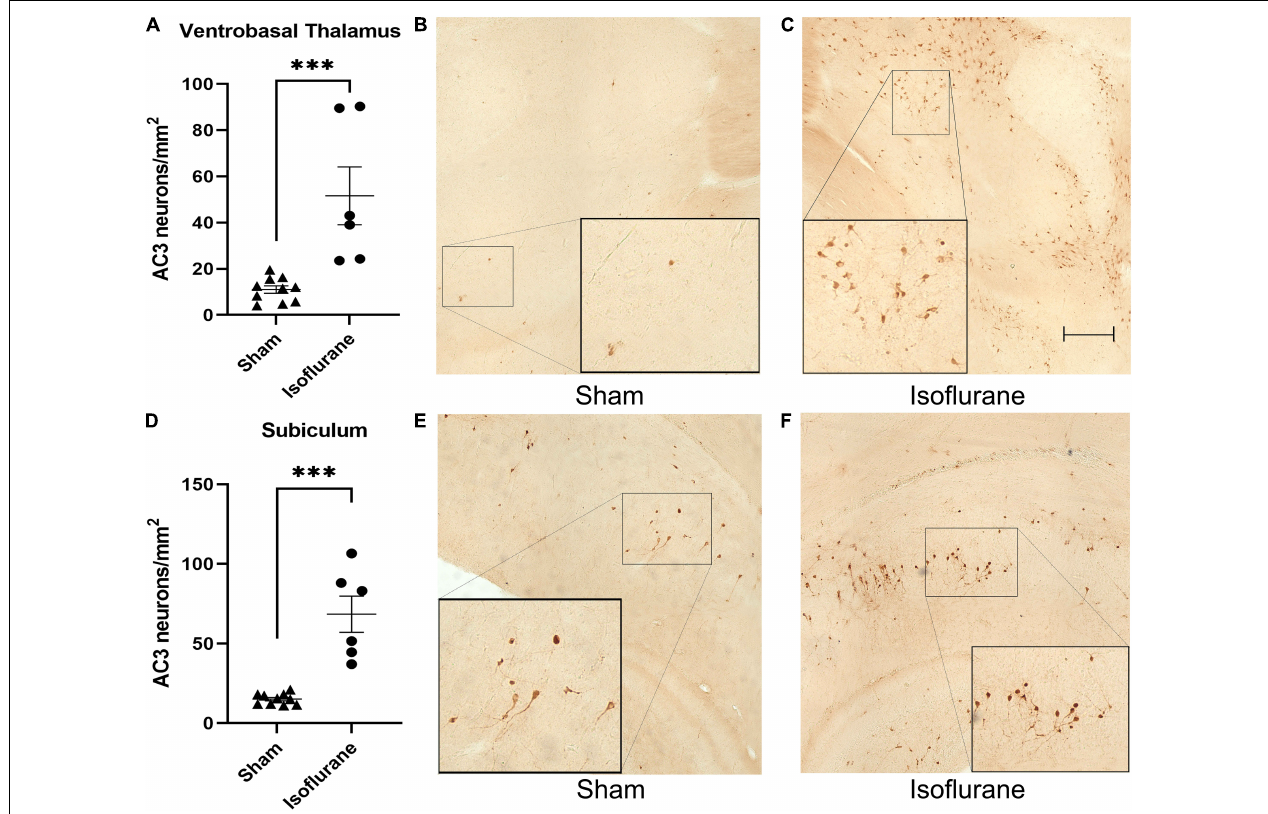
FIGURE 2 | Neonatal isoflurane exposure causes profound acute neurotoxicity. (A) Quantification of AC3 + neurons showing increased apoptotic profiles in the ventrobasal thalamus of rat pups 2 h after isoflurane exposure (*** P = 0.0002). (B,C) Side by side representative brain sections of ventrobasal thalamus showing normal physiological apoptosis in Sham animals and high density AC3 + neurons in Iso animals. (D) Quantification of AC3 + neurons showing increased apoptotic profiles in the subiculum 2 h after isoflurane exposure (*** P = 0.0002). (E,F) Side by side representative brain sections of dorsal subiculum showing basal levels of apoptotic pyramidal neurons in Sham animals compared to neurotoxic levels in Iso animals. Boxed areas represent zoomed in section from original image.